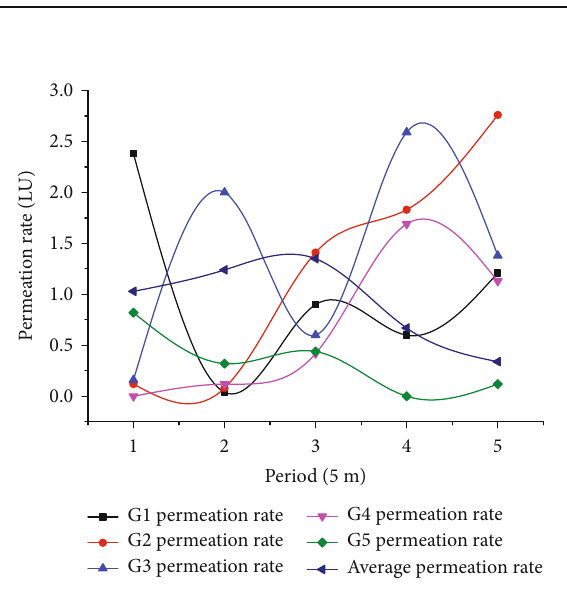
Figure 10: Permeability of test hole G1-G5.